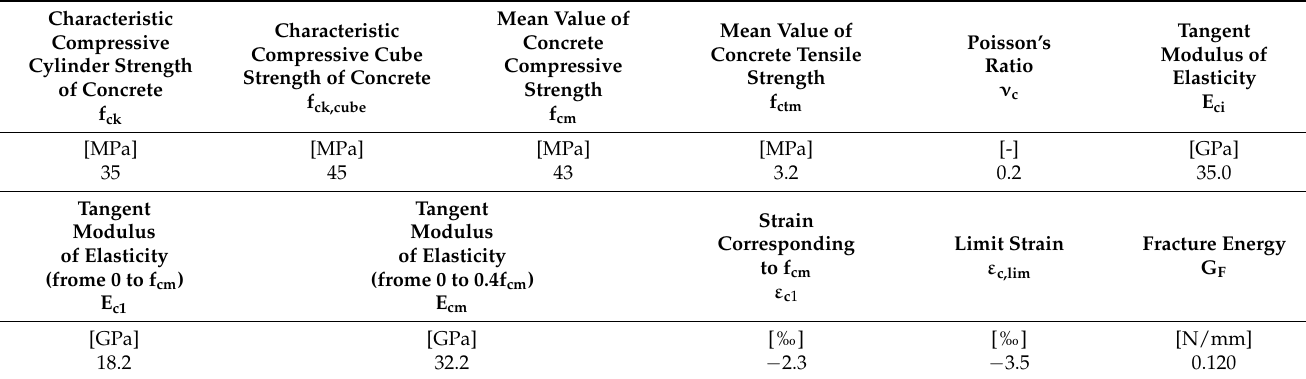
Table 8. Concrete parameters in numerical simulations.